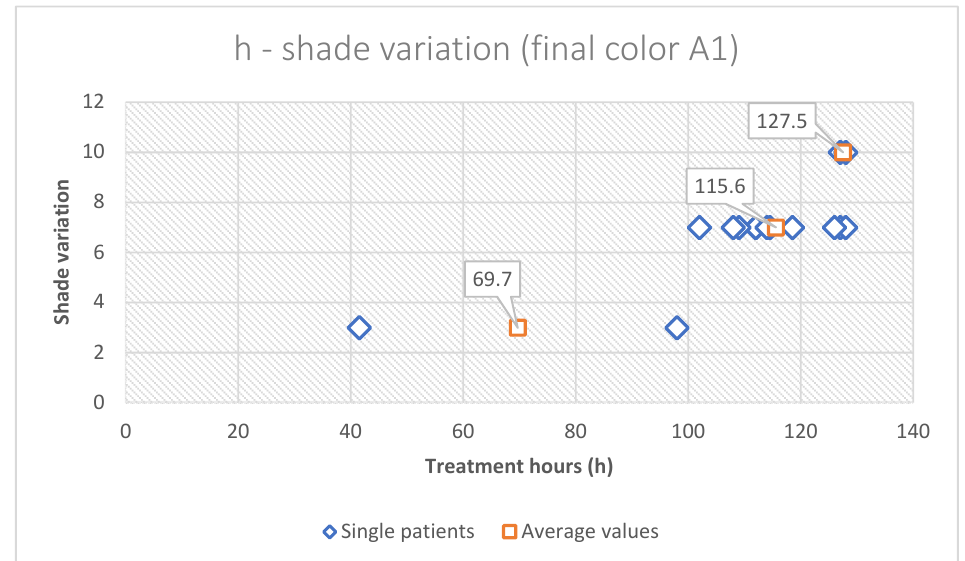
Figure 6. Results of dental-whitening treatments recorded for the 20 patients participating in the study: final shade recorded ( a ) and shade variation ( b ).